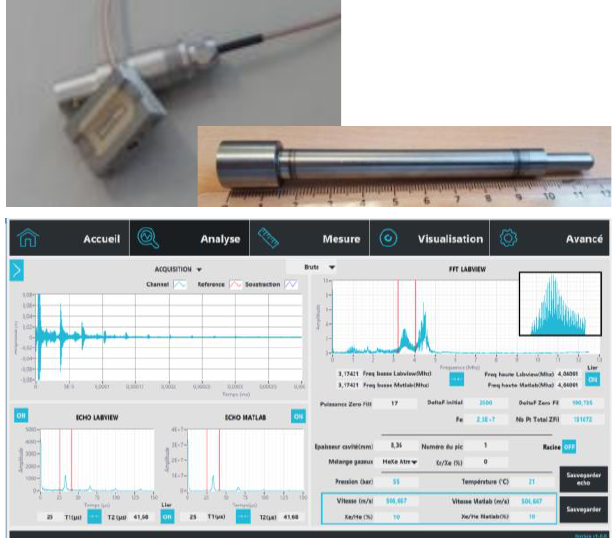
Fig. 4. Ultrasonic sensor. Top left: the sensor and its connector. Top right: the plenum cavity on which the sensor is stuck. Bottom: the associated HORTUS software (example of measurement on a cavity filled with a 10%Xe in He standard gas mixture at 55bar and room temperature).